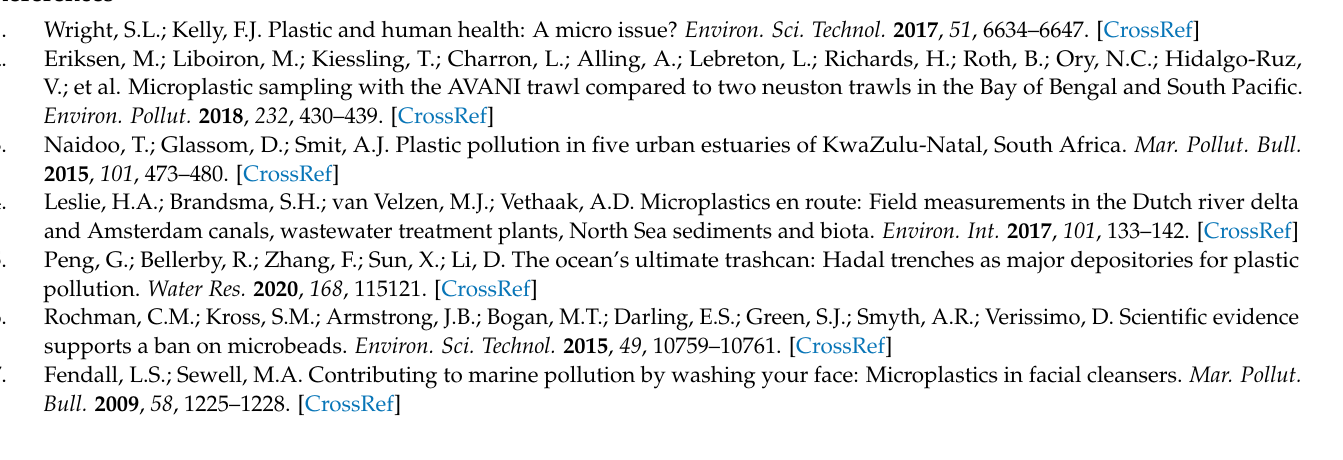
Figure S4: Feces of adult (A) and young (B) B. glabrata in control groups over 48-h and 21-d exposure, Table S1: Overview of the experimental design for experiment I-II, Table S2: Statistical parameters of size distribution ( µ m) of microbeads in different media for 48-h bioassay, Table S3: Statistical parameters of size distribution ( µ m) of microbeads in different media for 21-day